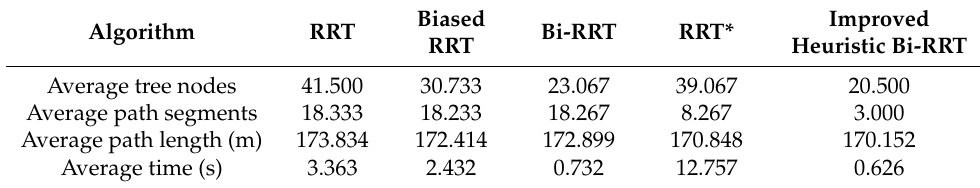
Table 4. Performance measures in the curve